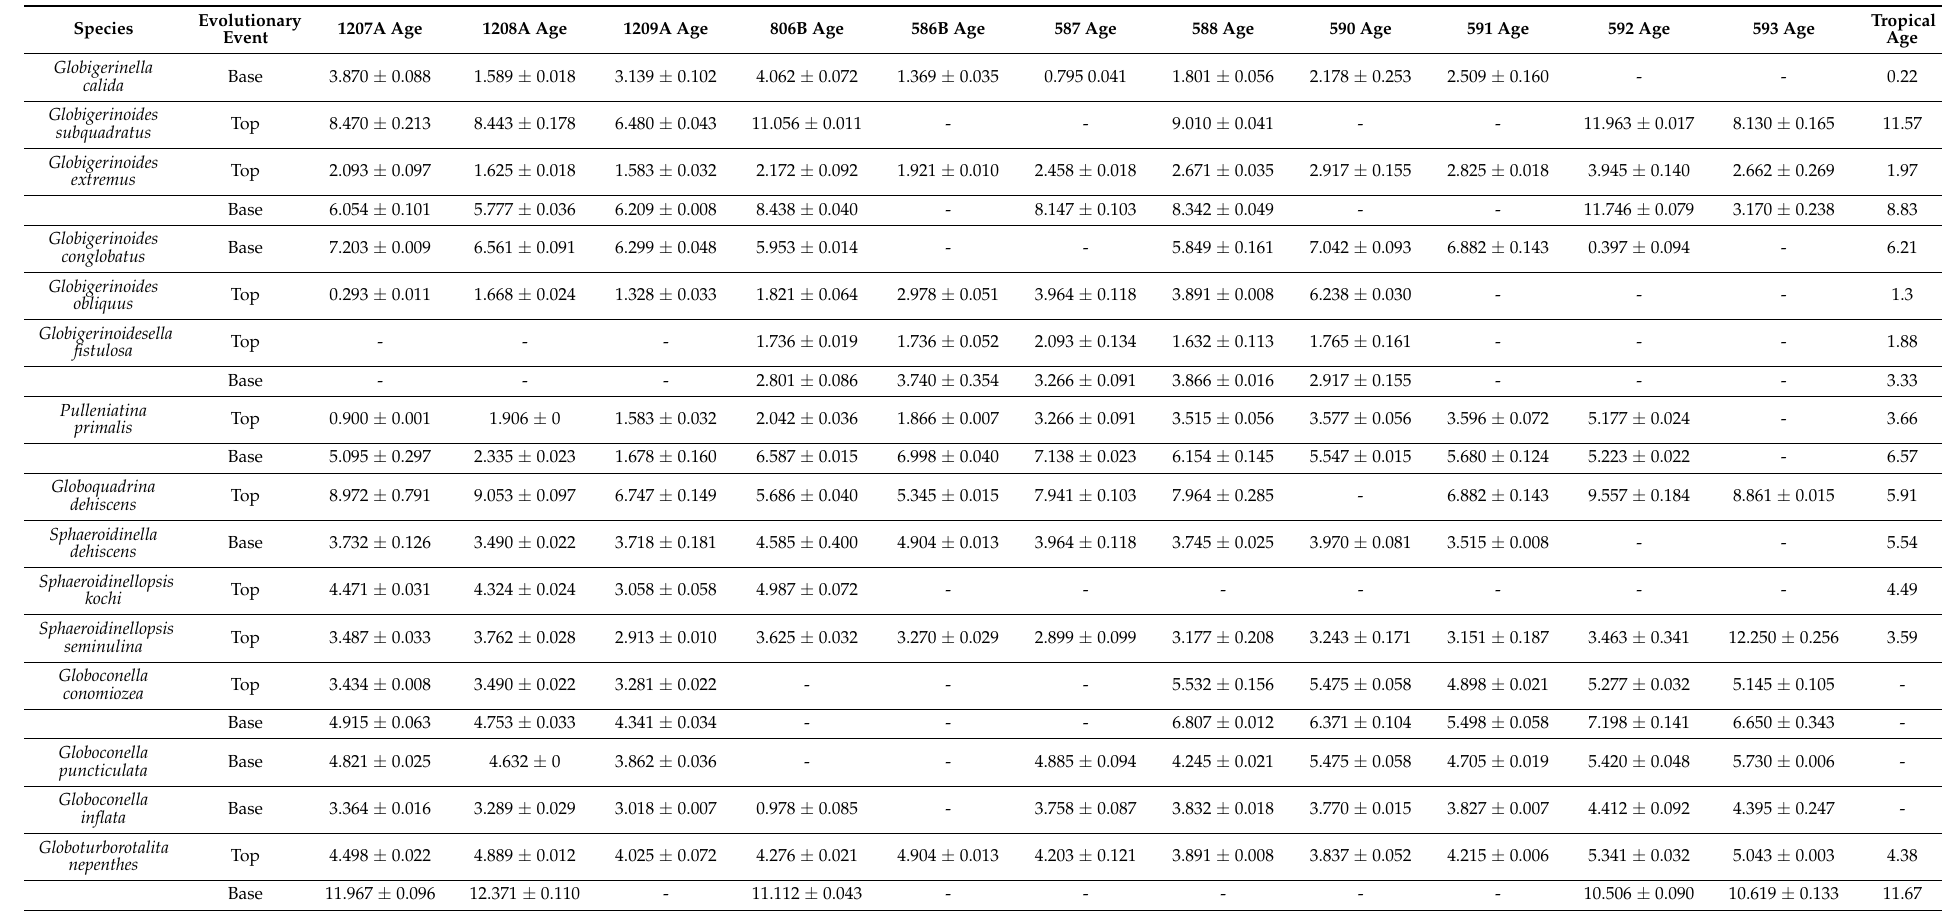
Table 2. Species and their evolution (base) and/or extinction (top) events with age error, as calibrated from magnetostratigraphy or calcareous microfossil biostratigraphy from the northwest Pacific (Holes 1207A, 1208A, and 1209A), the western equatorial Pacific (Holes 806B and 586B), and the southwest Pacific (Sites 587, 588, 590, 591, 592, and 593), and dates of datums from the global tropical planktic foraminiferal biozonation of King et al. [13] (tropical). All ages and age errors are reported in millions of